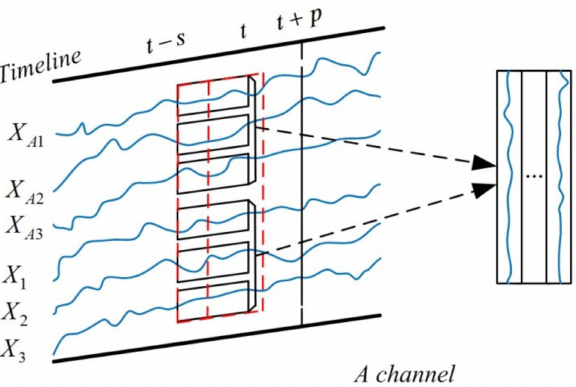
Figure 3. Time-varying delay input layer structure of the A channel of